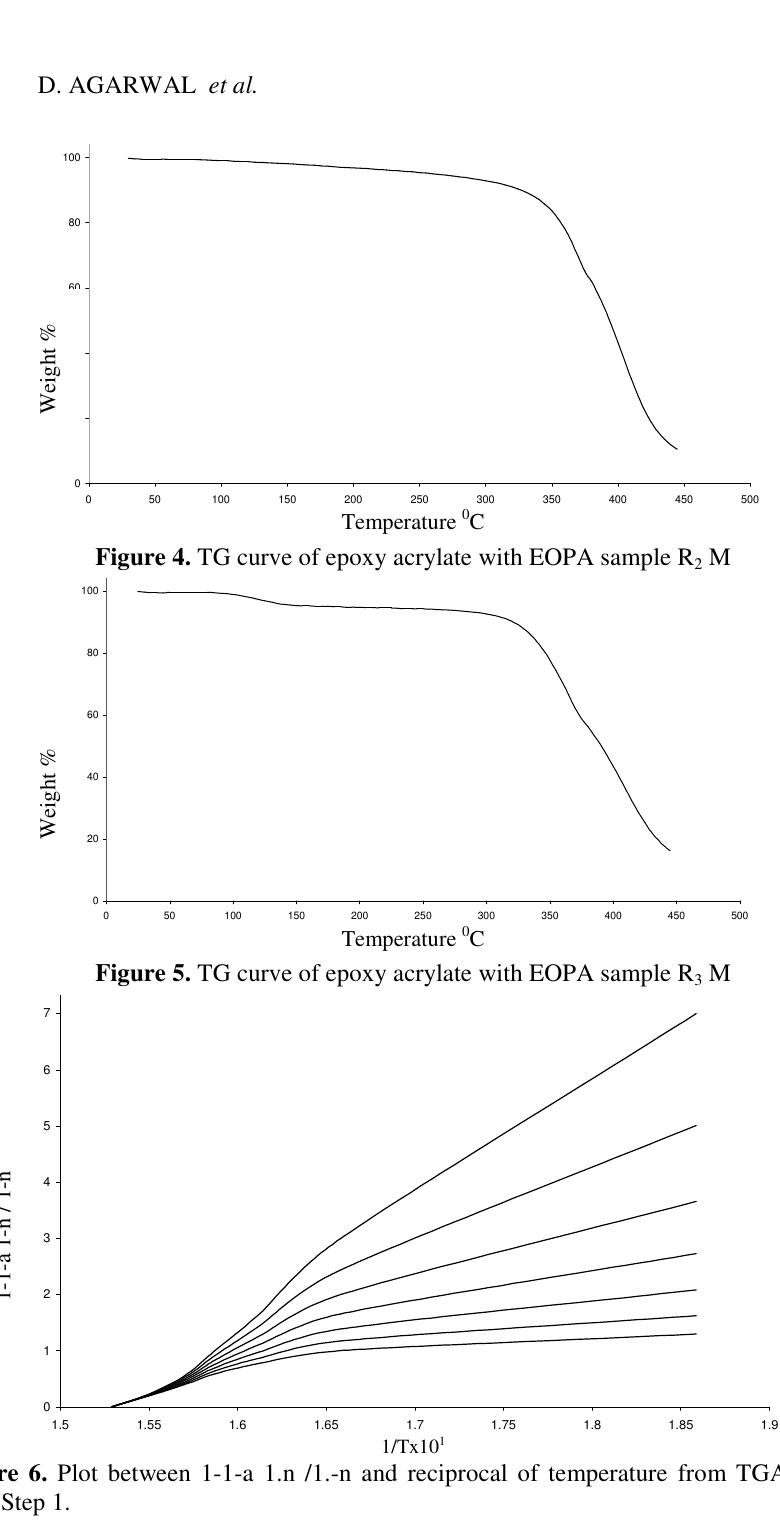
Figure 6. Plot between 1-1-a 1.n /1.-n and reciprocal of temperature from TGA data for R M Step 1